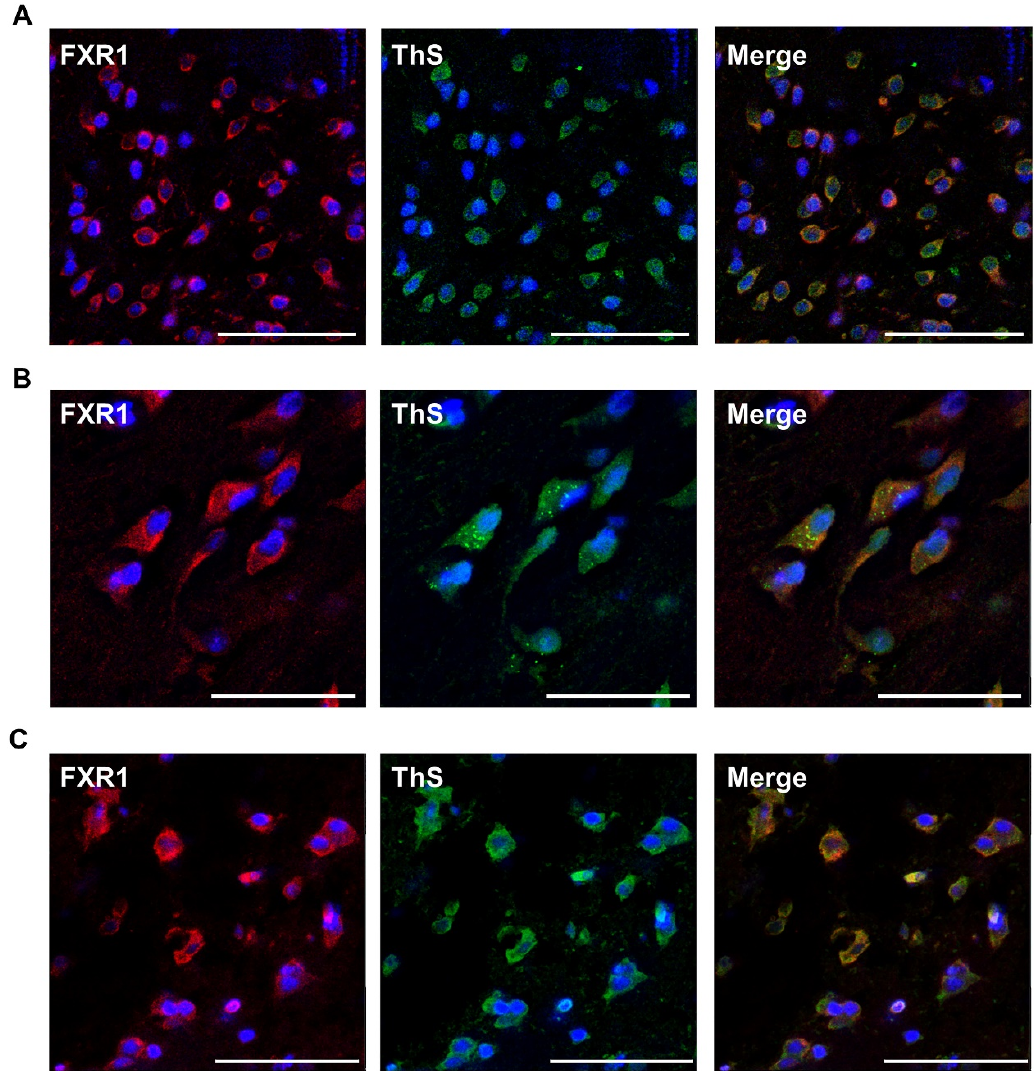
Figure 2. Colocalization of FXR1 (red signal) with amyloid-specific dye Thioflavin S (green signal) in neurons of frog ( A ), turtle ( B ), and chicken ( C ) brain sections. Blue signal corresponds to the nuclear dye DAPI; scale bar is 50 µm.